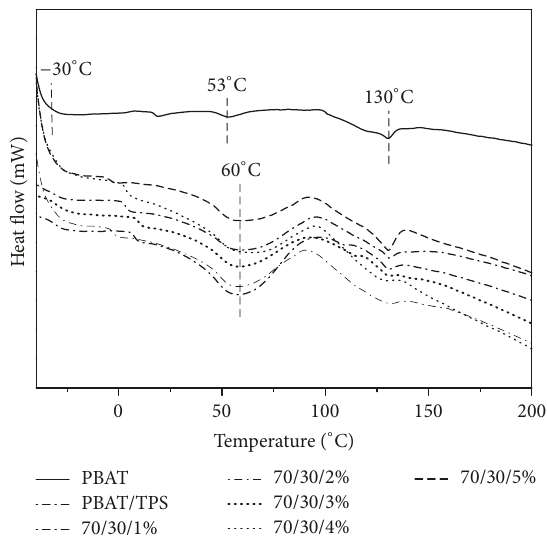
Figure 8: Differential thermal analysis for films.